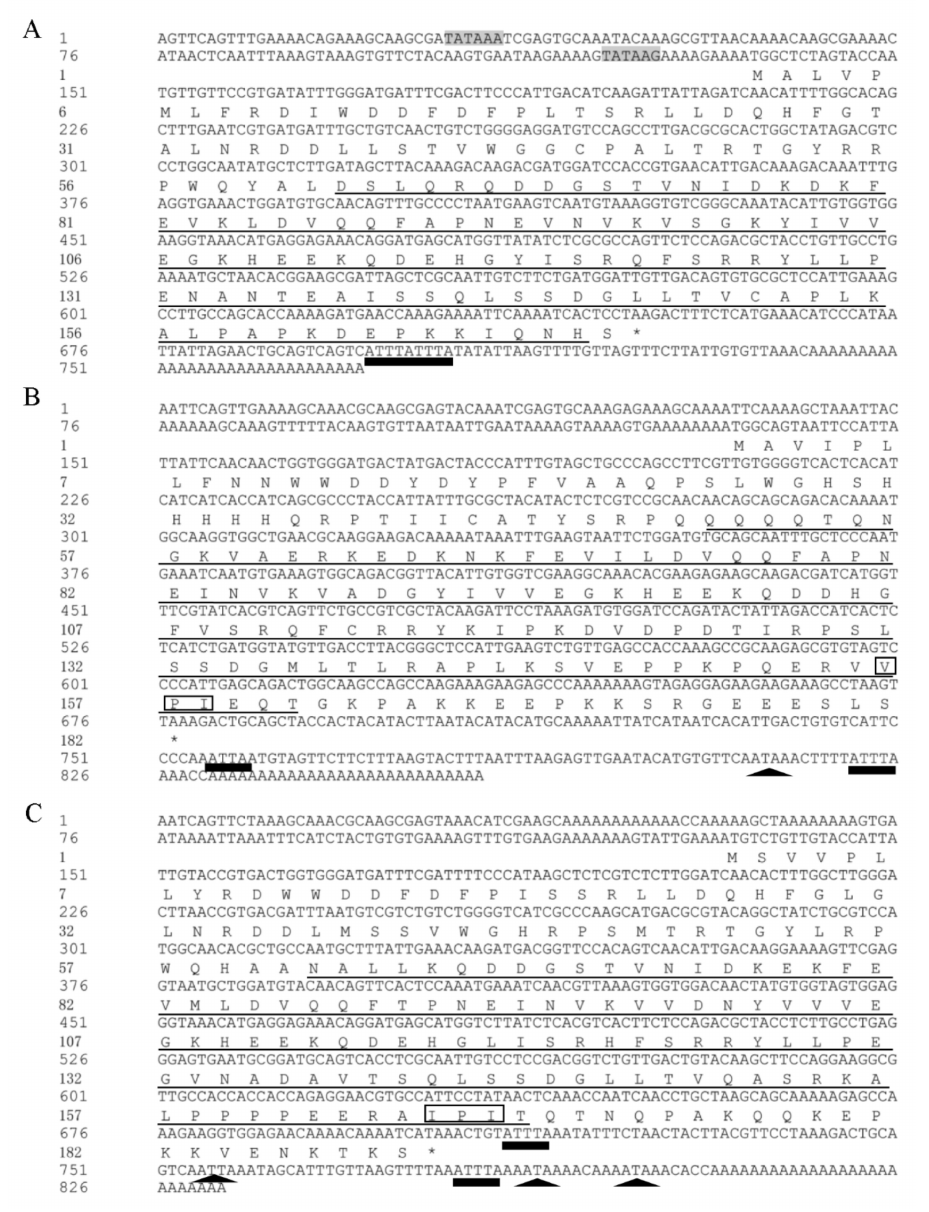
Figure 1. Nucleotide sequences for L. trifolii sHSP cDNAs and their predicted amino acid sequences. Nucleotide numbering starts with the adenine in the first methionine codon of the putative open reading frame. The highly conserved region, α -crystallin domain, is underlined. The asterisk indicates the translational termination codon. The putative polyadenylation signal is black triangles, the AT-rich element is black rectangles, the V / P / I motif is boxed and the TA-rich regions are indicated by shading. sHSP = small heat shock